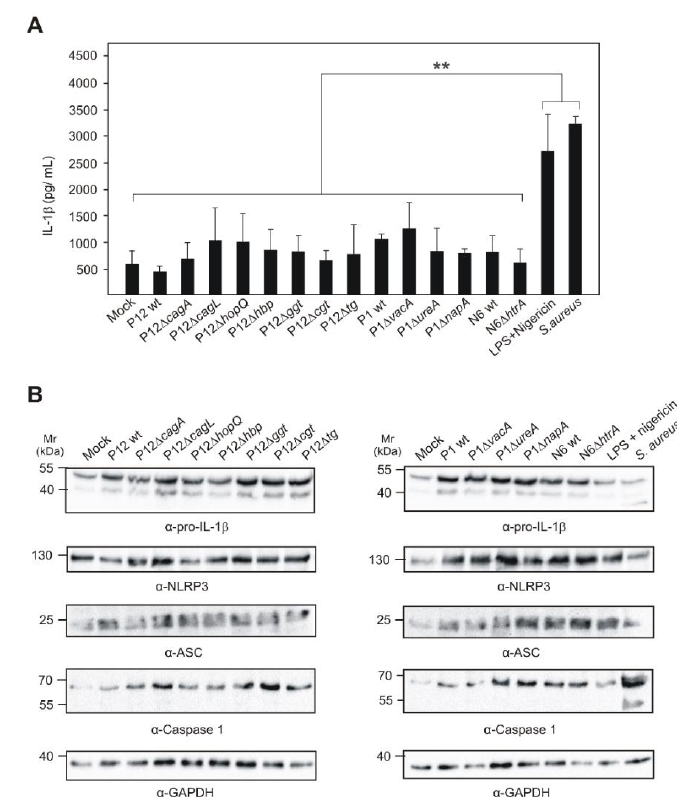
Figure 7. HEK293-NLRP3-INSOME cells infected with three different type-I strains and their respective isogenic mutants were used to analyse further activation of the NLRP3 inflammasome and were compared with LPS/Nigericin-treated or S. aureus- infected cells ( A ). The inflammasome components expression was further confirmed by Western blot in the mock control, H. pylori -infected, E. coli LPS/Nigericin-treated and S. aureus- infected cells ( B ). GAPDH protein immunoblots were used as a loading reference for relative expression. ** p ≤ 0.05